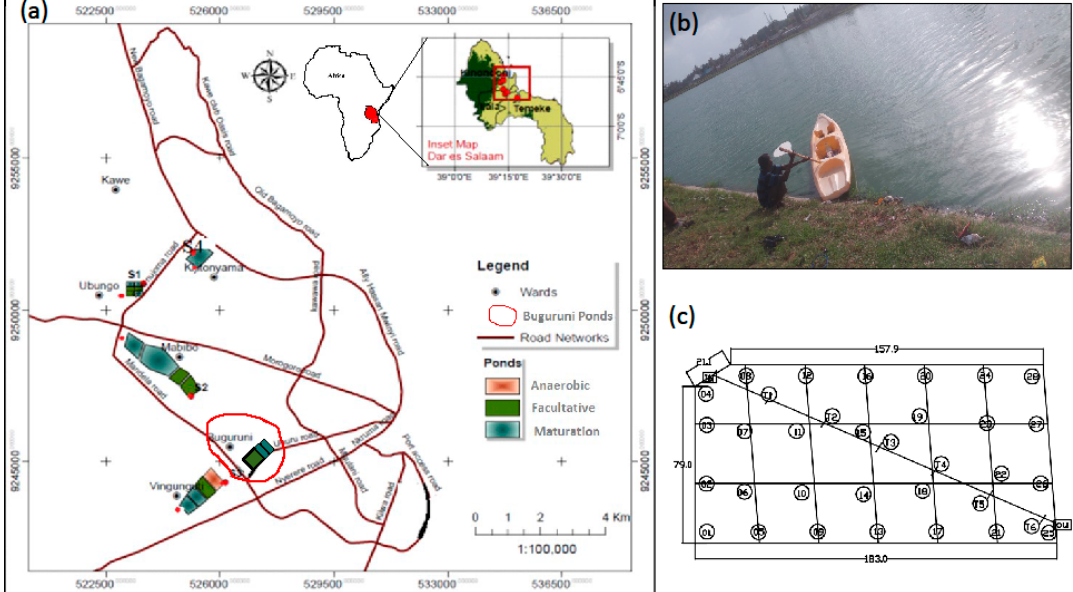
Figure 1. ( a ) Location of the Buguruni WSP from the inset map of Africa and Dar es Salaam city (modified from [18]); ( b ) Photo of the facultative pond taken during a sampling campaign in December 2016; ( c ) Sampling points (node numbers in